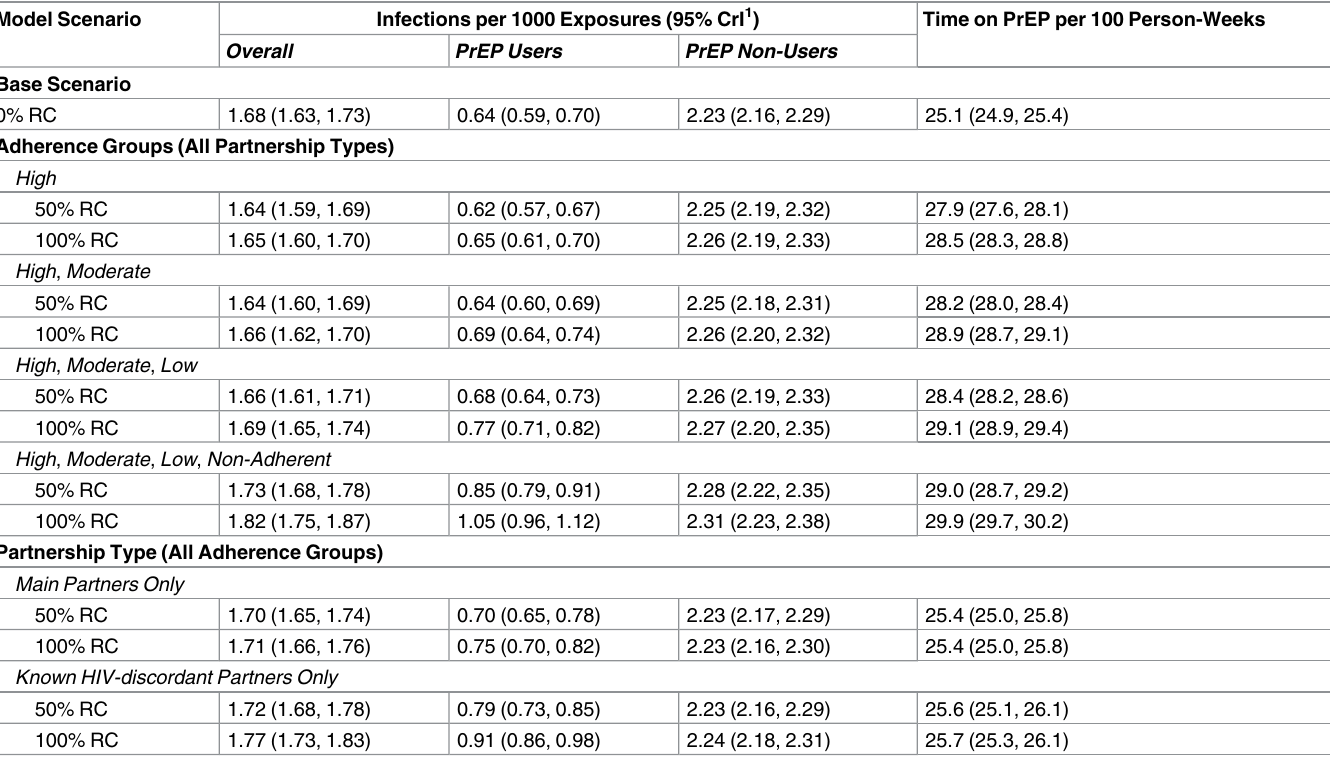
Table 2. Individual-Level Risk and Time on PrEP by Risk Compensation Level, by PrEP Adherence Level and Partnership Types, among US